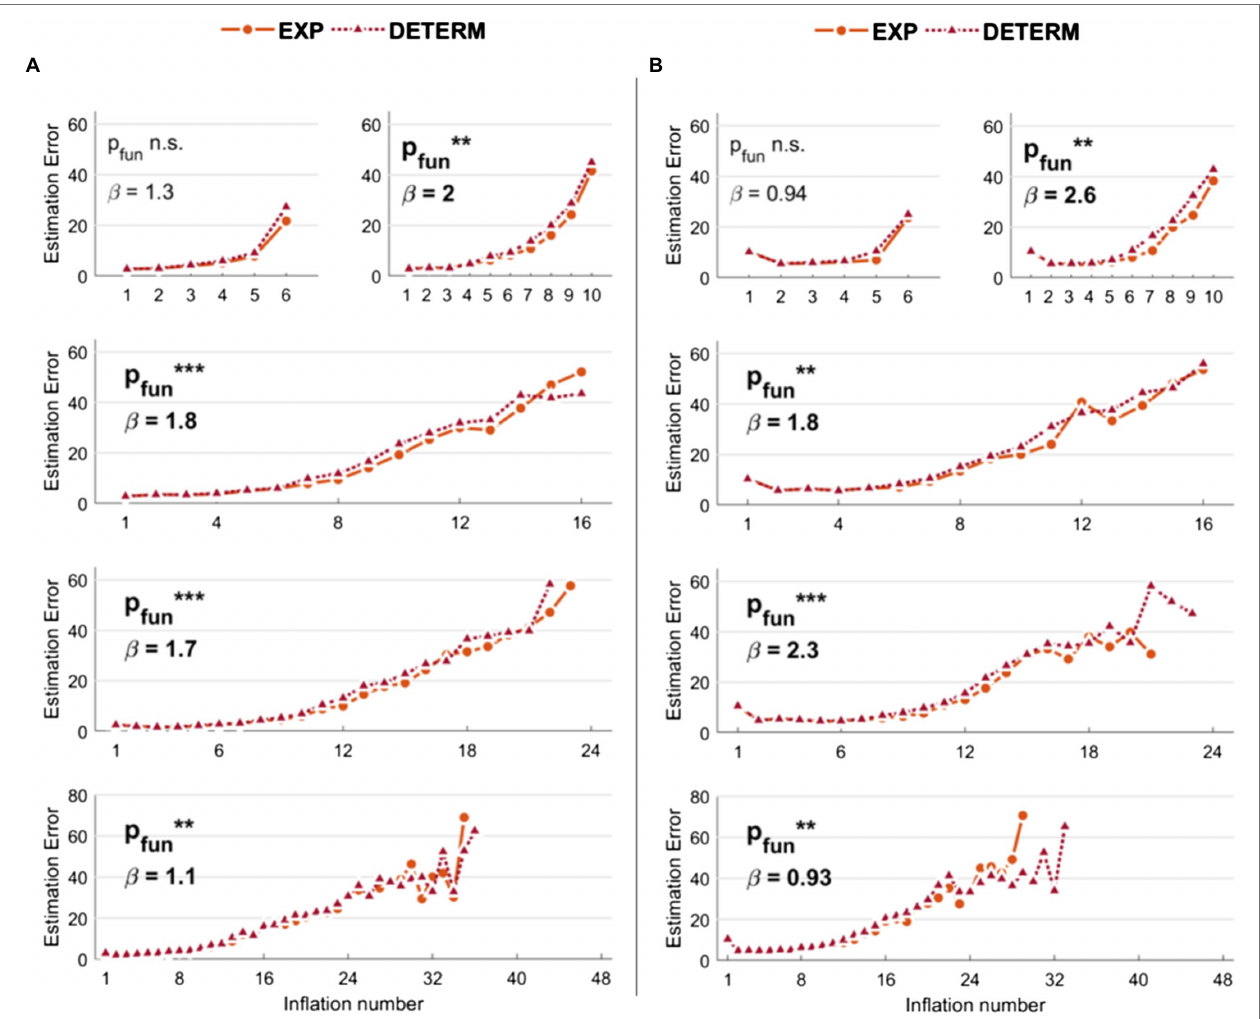
FIGURE 3 | Estimation errors of the stochastic versus deterministic Balloon Analog Risk Task (BART) implemented in the simulations. With respect to stochastic BART, only results relative to explosions modeled with exponential function and 50% threshold are shown for comparison. (A) Results with low noise levels in the virtual participants’ decisions. (B) Results with high noise levels in the virtual participants’ decisions. Legend: *** p < 0.001; ** p < 0.01; * p <